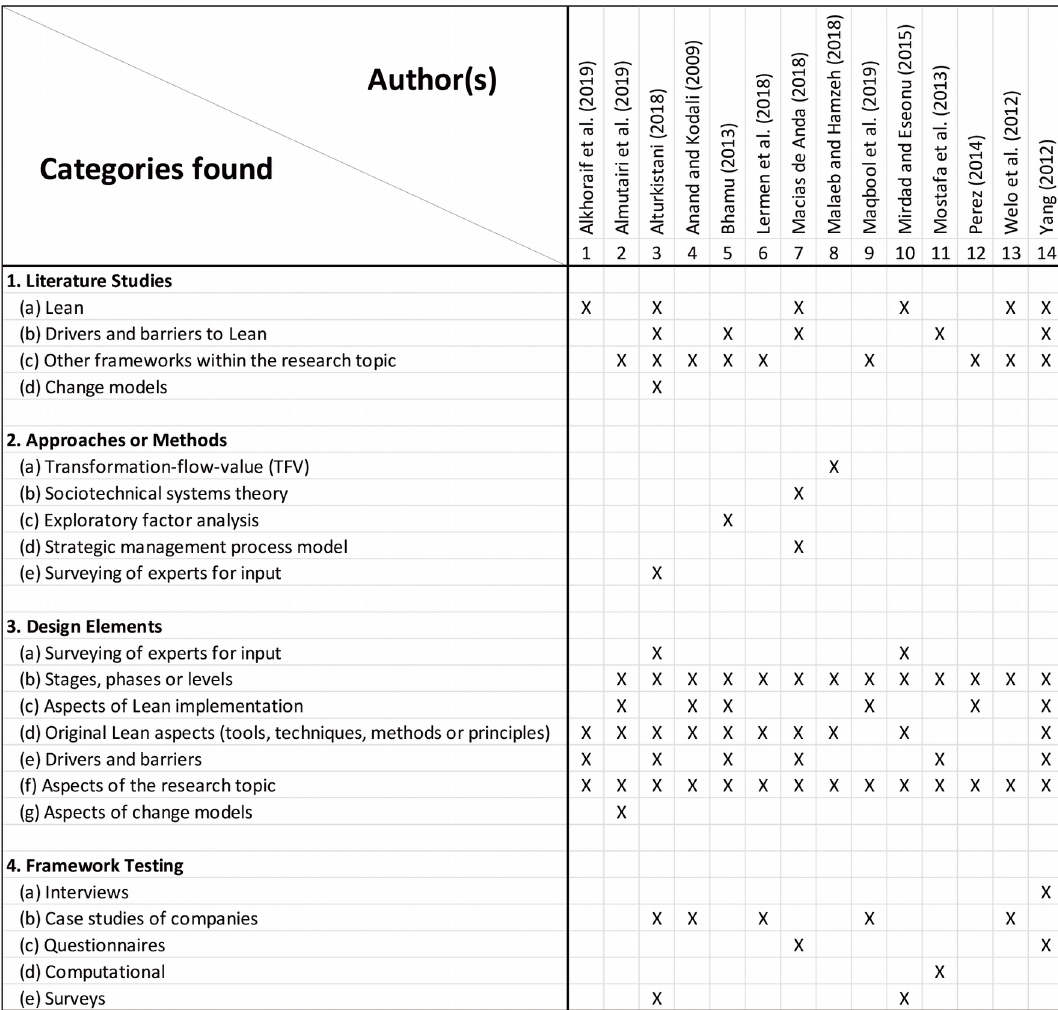
Figure 3. Breakdown of categories and themes found in the